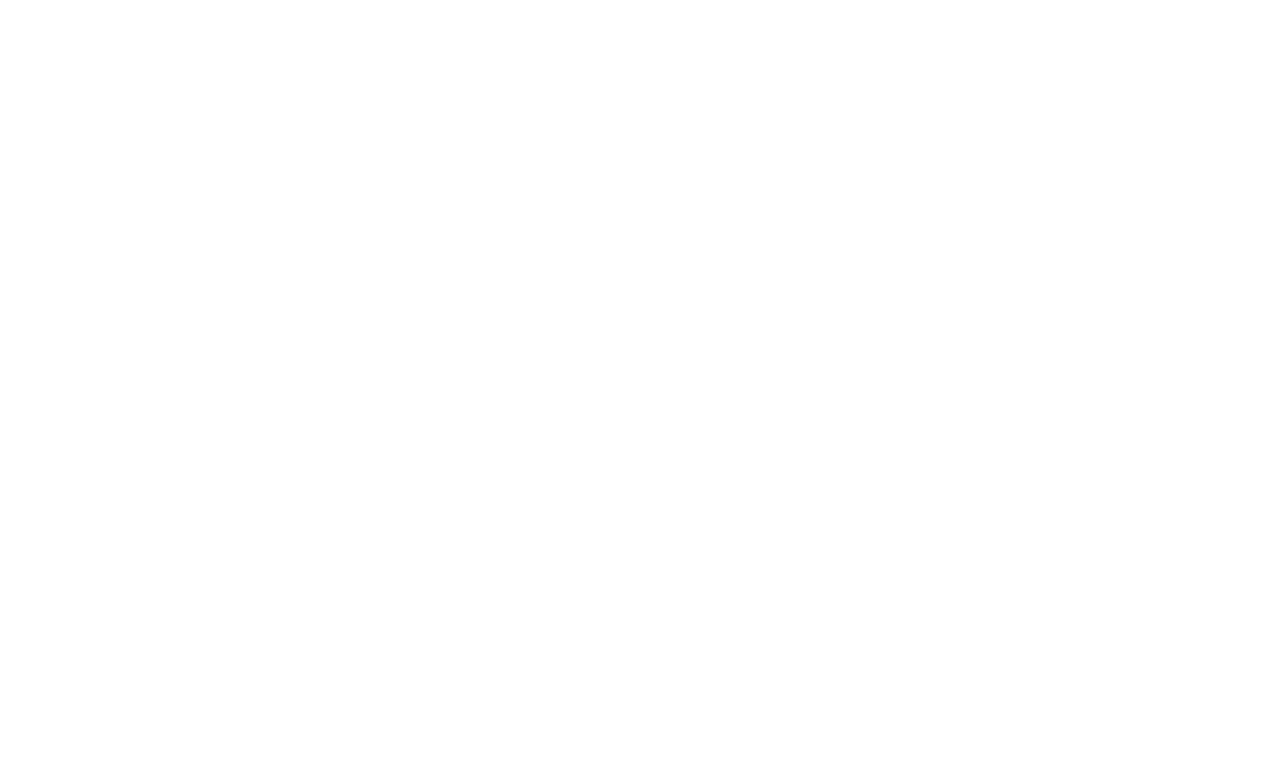
Appendix Figure B1 | Boxplots for the critical differences. diff_o = approach scores for happy/German, fearful/Turk (averaged) minus approach scores fearful/German, happy/Turk (averaged); diff_s = approach scores for happy/young, fearful/old (averaged) minus approach scores fearful/young, happy/old